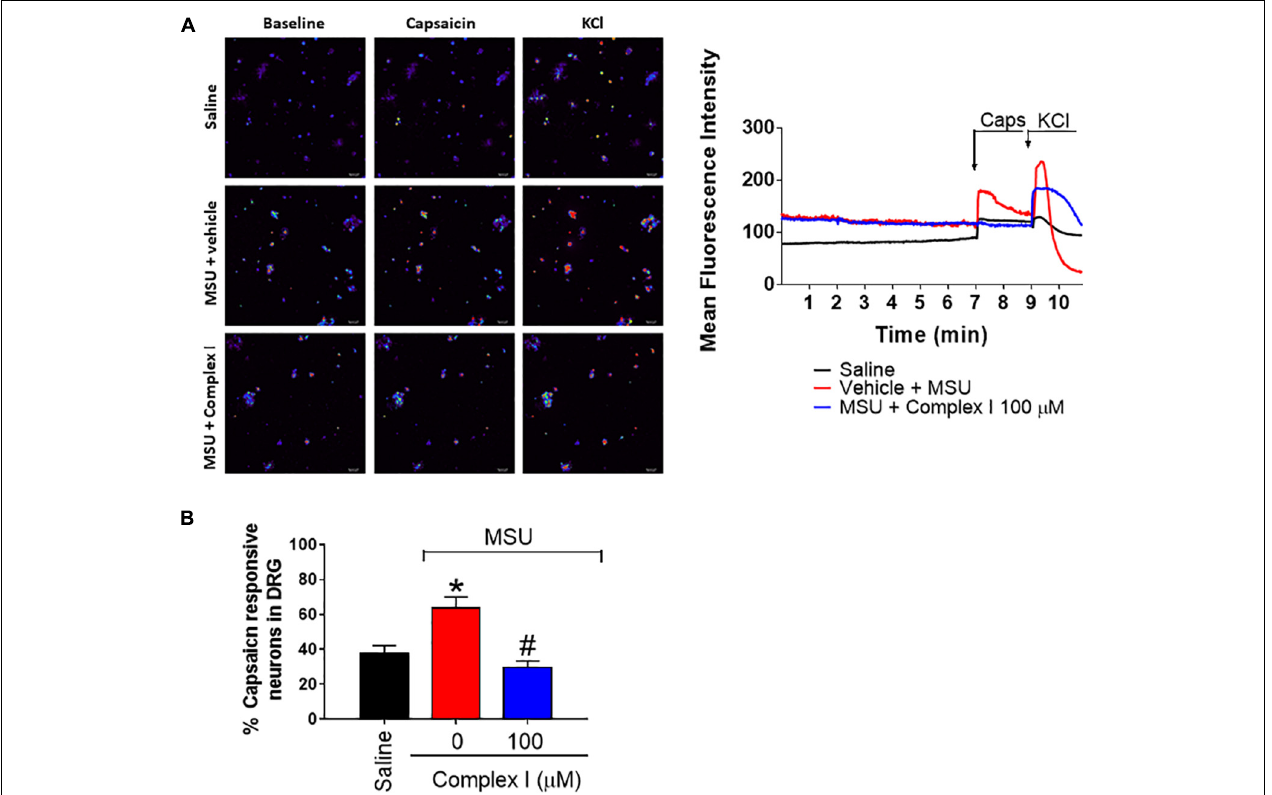
FIGURE 9 | Complex I inhibits MSU-induced TRPV1-dependent DRG nociceptor neurons activation. The in vivo injection of MSU (100 µ g/10 µ l/joint) increases the basal calcium detection in DRG neurons and also the responsiveness to capsaicin (TRPV1 agonist) compared to saline negative control group. Treatment with complex I significantly reduced the intensity of calcium detection (A) and the percentage of cells responding to capsaicin (B) . Results are expressed as mean ± SEM ( n = 5 per group per experiment, representative of two experiments). ∗ p < 0.05 compared to saline group and # p < 0.05 compared to MSU group. One-way ANOVA followed by Tukey’s